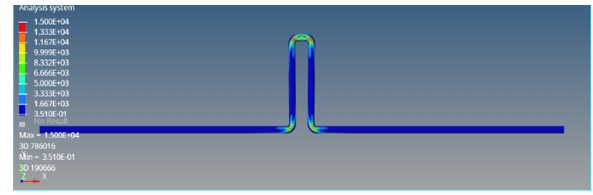
Figure 4: Stress occurring in the expansion loop